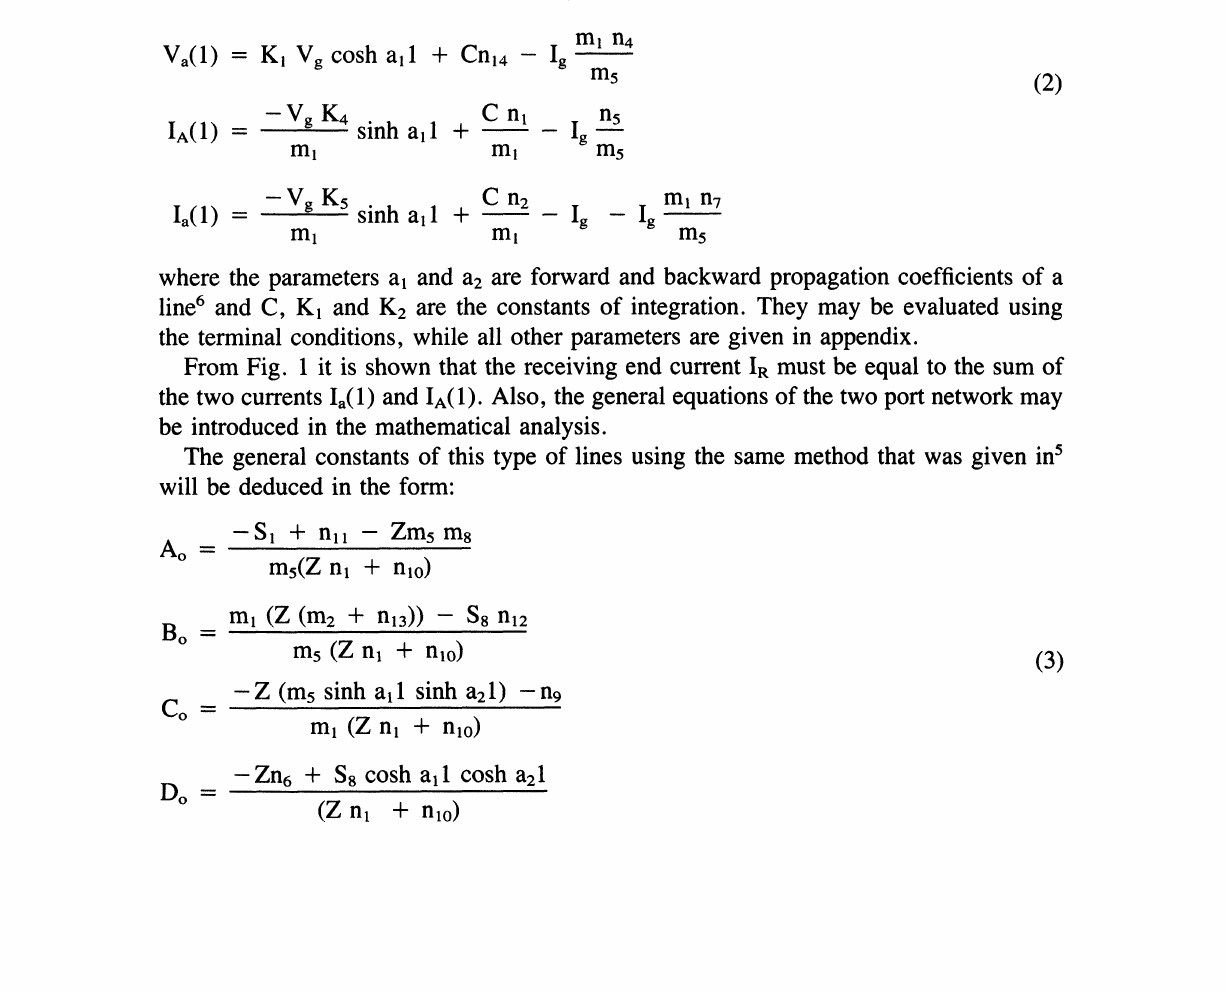
FIGURE The single line diagram of the suggested